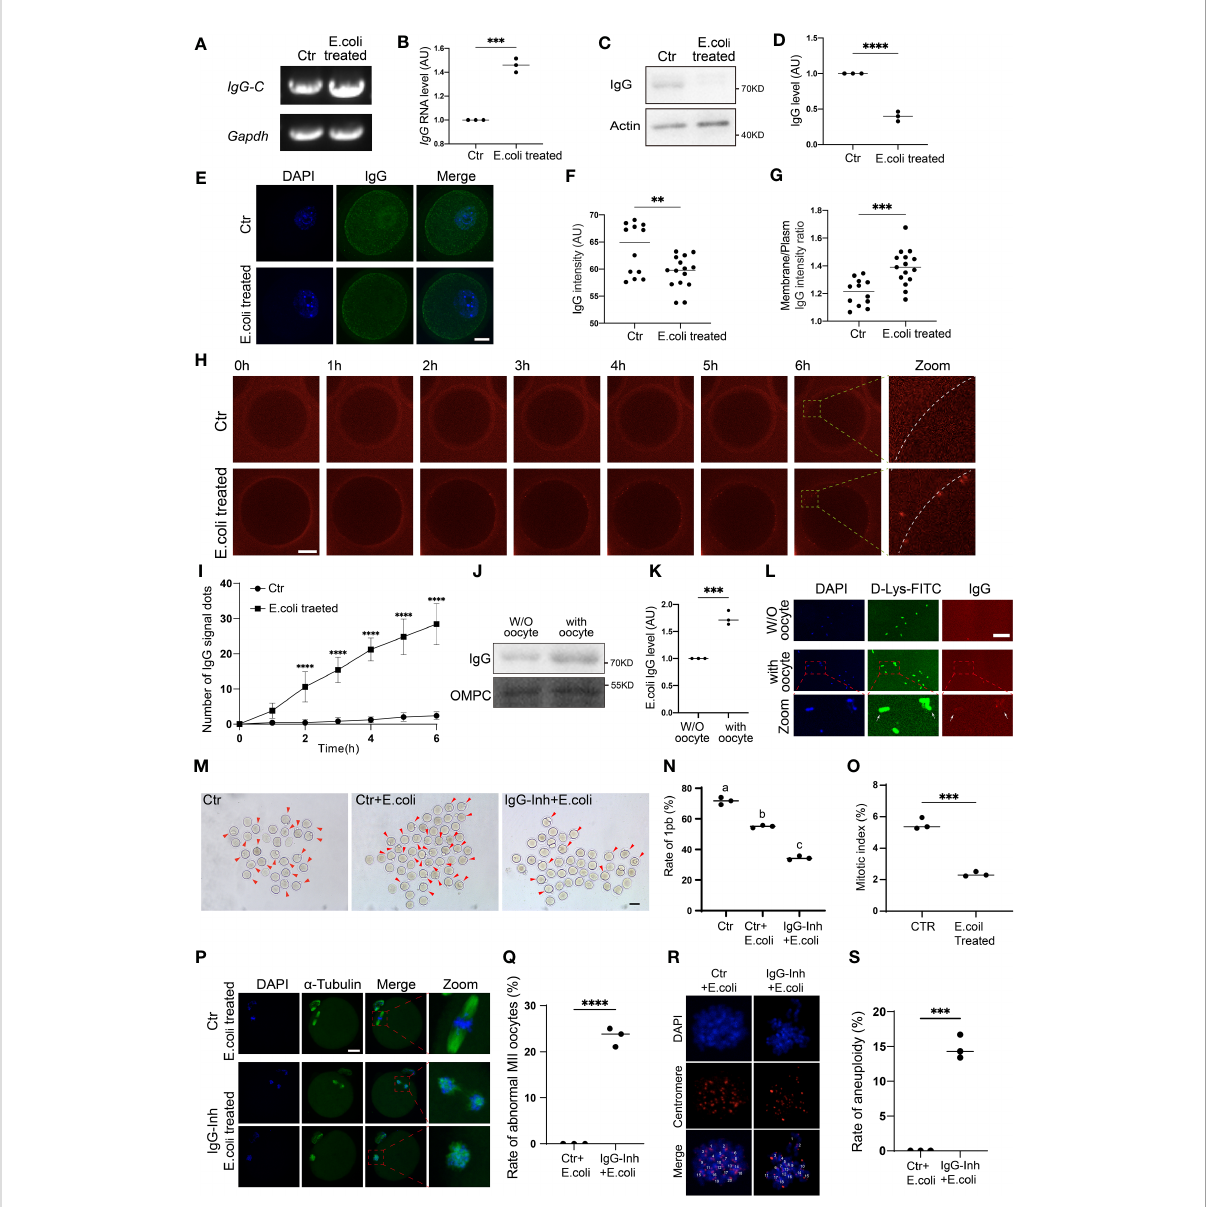
FIGURE 7 IgG functions to protect oocyte survival in response to E. coli stimuli (A – D) . (E) coli was added to the oocyte IVM medium. RT-PCR and quanti fi cation show that IgG-constant (IgG-C) mRNA level signi fi cantly increased on exposure to E. coli stimuli (A, B) , whereas Western blot shows that IgG protein level signi fi cantly decreased (C, D) . (E – G) Immuno fl uorescence shows that on exposure to (E) coli stimuli, IgG intensity within oocytes signi fi cantly decreased, however, the membrane/cytoplasm IgG ratio signi fi cantly increased. (H, I) Live image of fl uorescence dye (Cy2)-labeled IgG and quanti fi cation show that E. coli supplemented into the oocyte IVM medium caused increased IgG aggregates on the oocyte membrane. (J, K) Western blot shows that after (E) coli is supplemented into the oocyte IVM medium, the IgG protein level signi fi cantly increased in E. coli pellets. (L) Immuno fl uorescence shows that E. coli supplemented into the oocyte IVM medium caused signi fi cantly increased IgG staining on E. coli. A region in oocyte-challenging E. coli was magni fi ed and is shown below. DNA in blue, E. coli (D-Lys-FITC labeled) in green, IgG in red. (M – O) IVM and quanti fi cation show that the mitosis and meiosis decrement extent of E. coli-challenged NIH3T3 (from 5.52% to 2.35%, O) was much larger than that of E. coli-challenged oocytes (from 71.65% to 55%, N). However, IgG inhibition further decreased the oocyte maturation rate from 55% to 34.4% (N) . P. Side-by-side comparison of E-coli-treated NIH3T3 cells and oocytes showed that the decrement extent of the mitotic index was much larger than that of the oocyte maturation rate. (P, Q) Immuno fl uorescence and quanti fi cation showed that IgG inhibition caused a signi fi cantly increased percentage of maturated oocytes with an abnormal chromosome alignment and spindle structure. (R, S) Chromosome spread, immuno fl uorescence and quanti fi cation of aneuploidy showed that IgG inhibition caused a signi fi cantly increased percentage of MII oocytes with aneuploidy. Gapdh , Actin or OMPC (Escherichia coli Outer Membrane Pore Protein C) was used as a loading control. Scale bars, 20 m m. ** indicates p < 0.01, *** indicates p < 0.001. **** indicates p < 0.0001. Difference lower-case letters indicate signi fi cant difference between two